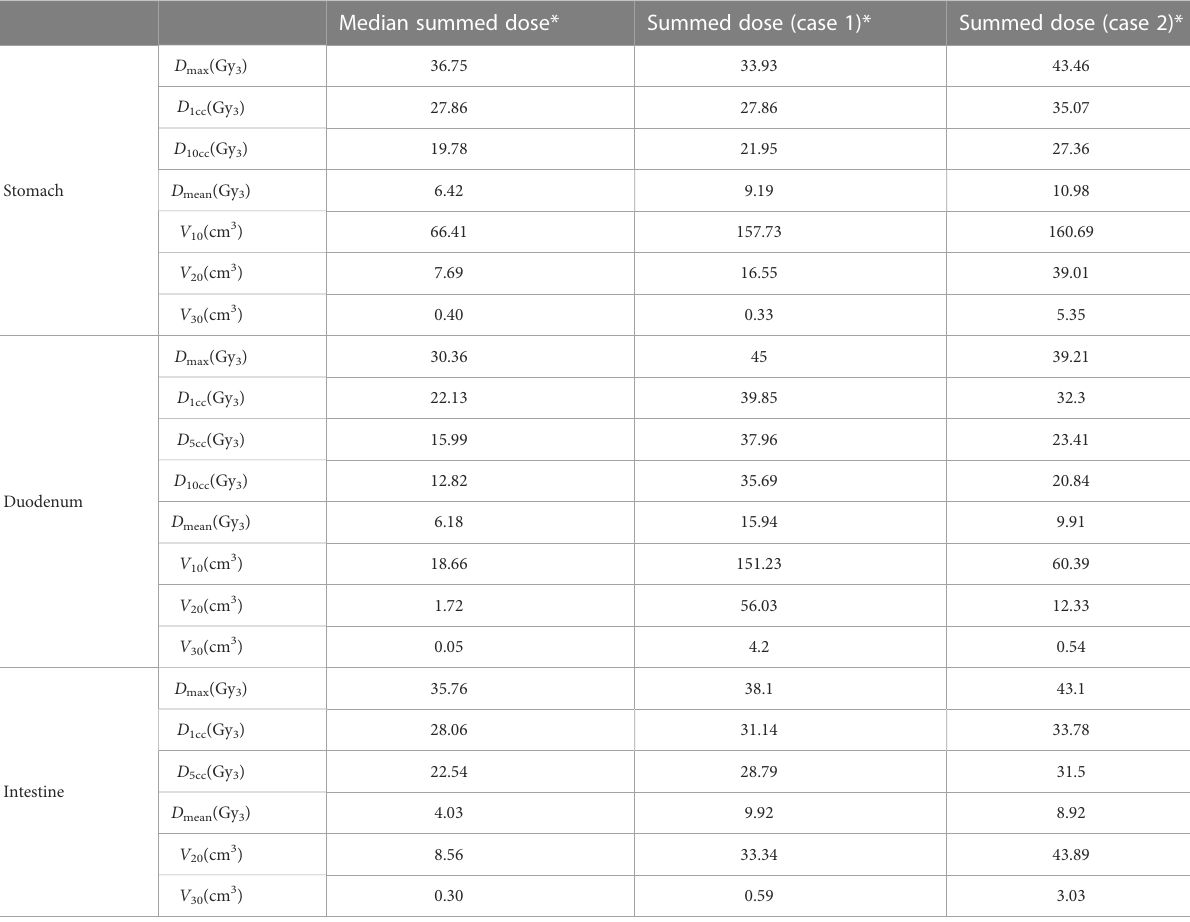
*All of the summed doses were calculated based on the correlation between dose attenuation and time